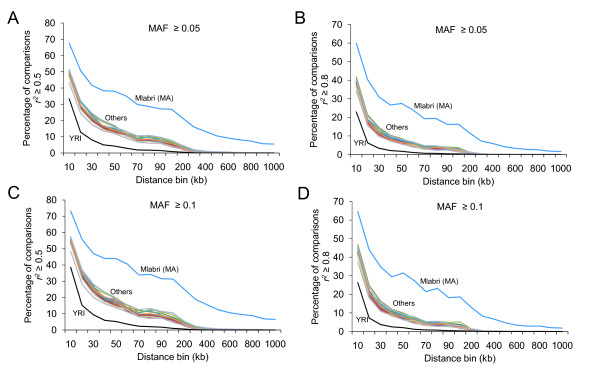
Decay of linkage disequilibrium (LD) over distance. LD was measured by pairwise comparison (A&C, r2 ≥ 0.5; B&D, r2 ≥ 0.8) between markers that had minor allele frequency ≥ 0.05 (A, B), ≥ 0.1 (C, D) and that fell into the same intermarker distance bin. Blue lines denote Mlabri, black lines denote YRI, others include the rest 15 population samples.